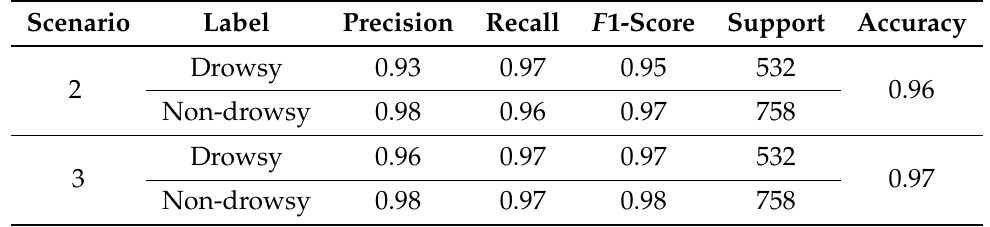
Table 6. Results of training in scenarios 2 and 3.